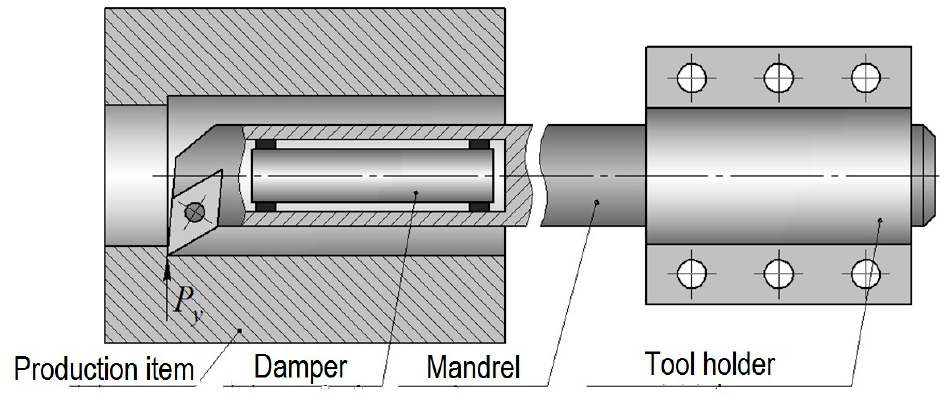
Figure 1. The machine node (schematically).